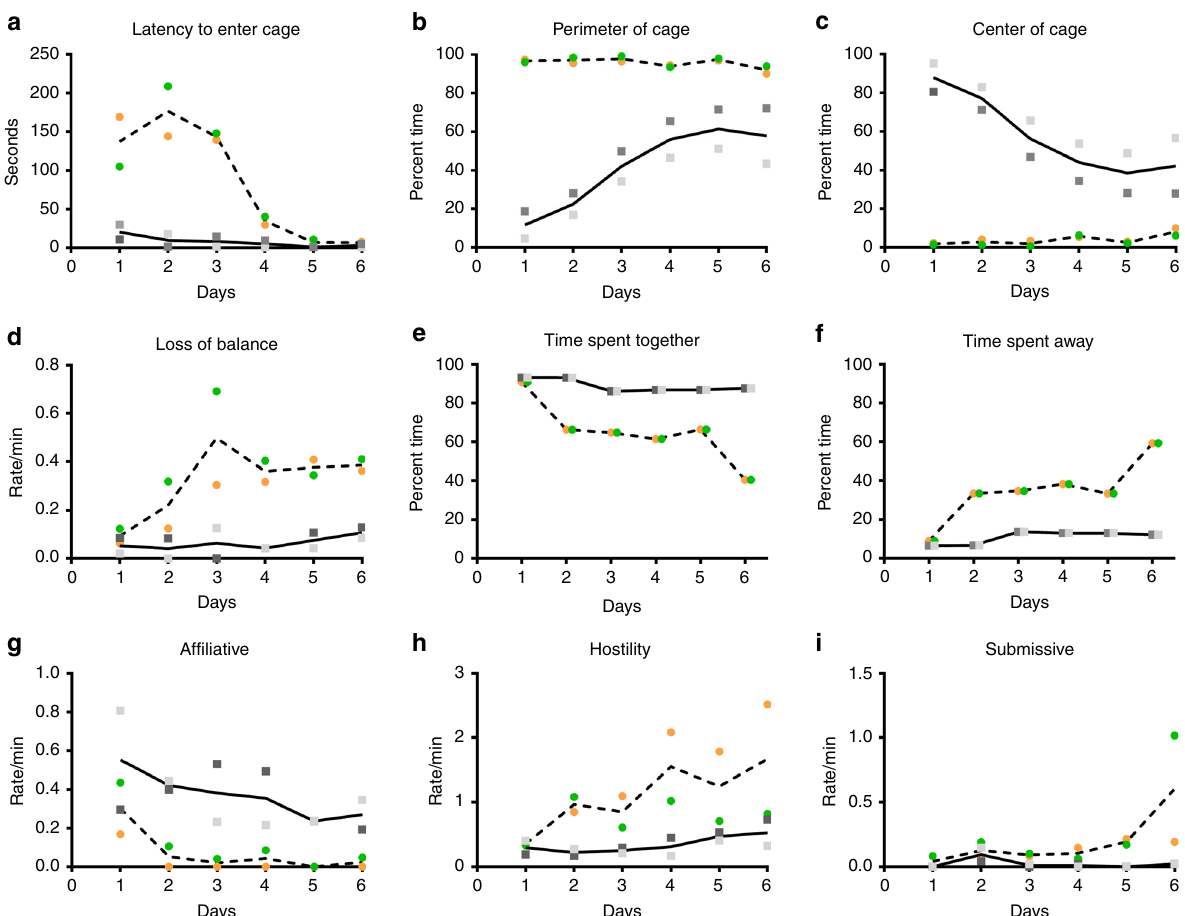
Fig. 1 Altered socioemotional behavior in infant RMs with postnatal ZIKV infection. a – i Illustrates the change in behavioral responses of ZIKV-infected infant RMs (dashed line with circles; green = ZIKV-5 and orange = ZIKV-6) and controls (solid line with squares; dark gray = Control-1 and light gray = Control-2) across 6 days of testing in a large novel play cage. Latency to enter the cage ( a ) was measured in seconds, while speci fi c behaviors were measured as rates per min ( d , g – i ) or as a percentage of total observation time ( b , c , e , f